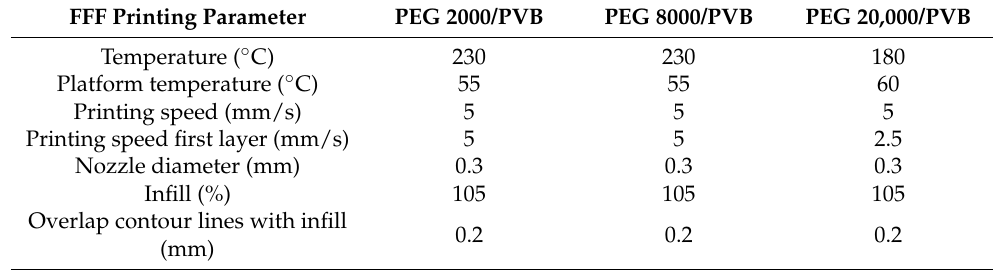
Table 3. FFF printing parameters for different PEG/PVB systems (solid load: 60 vol%, 5 wt% SA as surfactant).